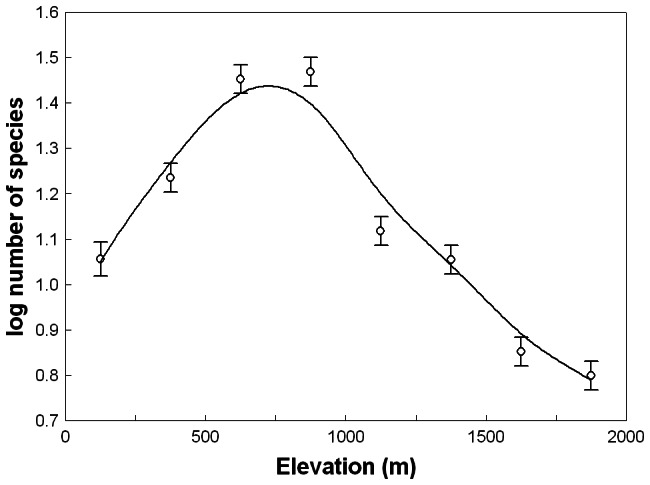
Generalized area-controlled relationship between phanaeine species richness and elevation below 2000 m.Data points represent averages of curves in Figures 3 and 4. Vertical bars denote 95% confidence intervals of a one-way ANOVA (F = 244.04, P<0.0001). The curve was fitted by distance-weighted least squares smoothing.